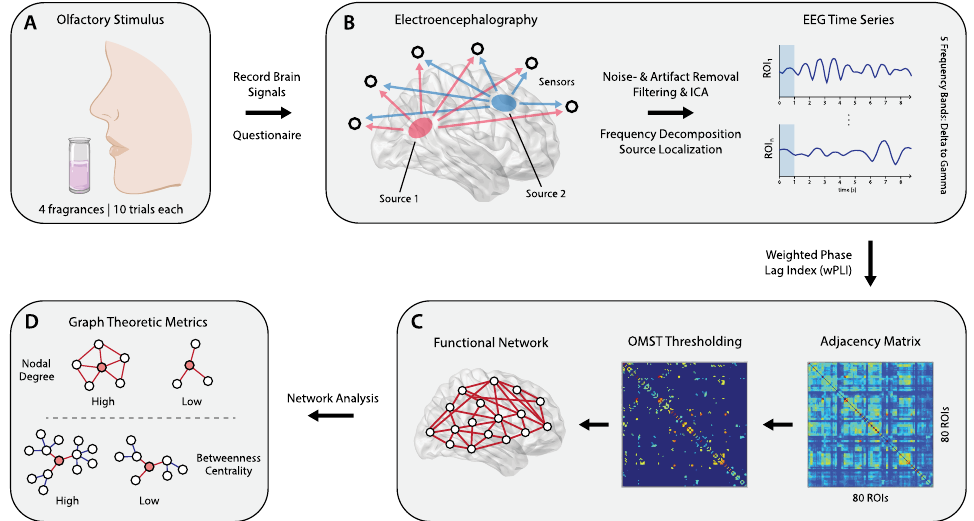
Figure 1. Overview of the study’s methodology. EEG signals recorded in response to pleasant olfactory stimuli exposure ( A ) were preprocessed and source localization was performed to estimate the cortical sources generating scalp level signals ( B ). Then, functional connectivity between source- level EEG signals was estimated using the weighted phase lag index (wPLI), yielding 80 adjacency matrices that store pairwise connectivity values between sources (ROIs). The wPLI matrices were subject to further thresholding based on orthogonal minimum spanning trees (OMST) ( C ), resulting in functional connectivity networks that were analyzed ( D ) to estimate graph theoretic metrics (nodal degree, clustering coefficient, betweenness centrality). Using said metrics, statistical analyses were carried out to quantify cortical dynamics induced by olfactory stimuli of different perceived pleasantness. This included direct comparisons of experimental factors via paired samples t -tests, as well as utilizing graph metrics to assess hemispheric laterality